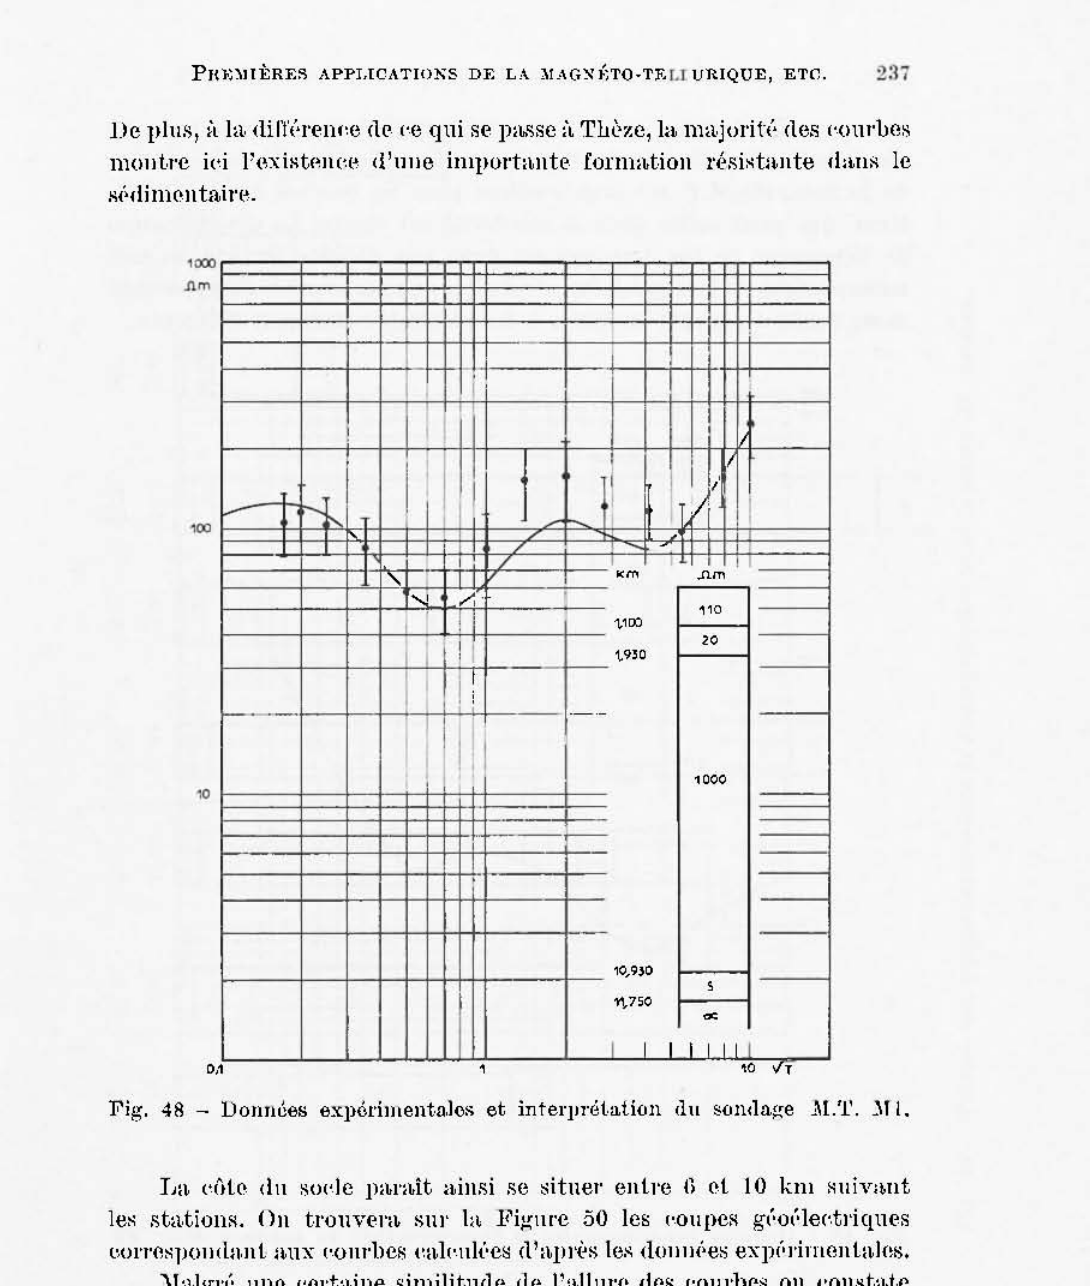
l,a ('file dll ~o('lc paom it ainsi sc ~itllel' enlre fl el lO km